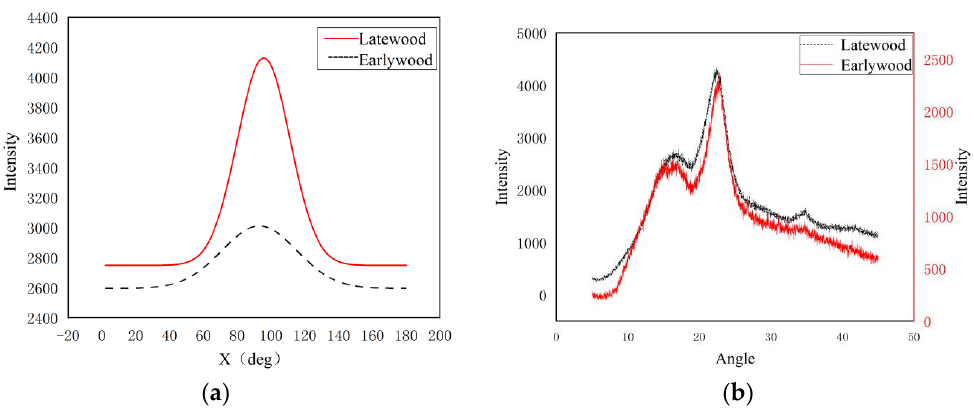
Figure 6. XRD of earlywood and latewood. ( a ) MFA; ( b ) crystallinity.